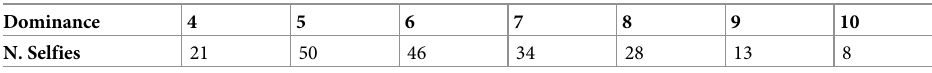
Table 3. Frequency distribution of number of dominant